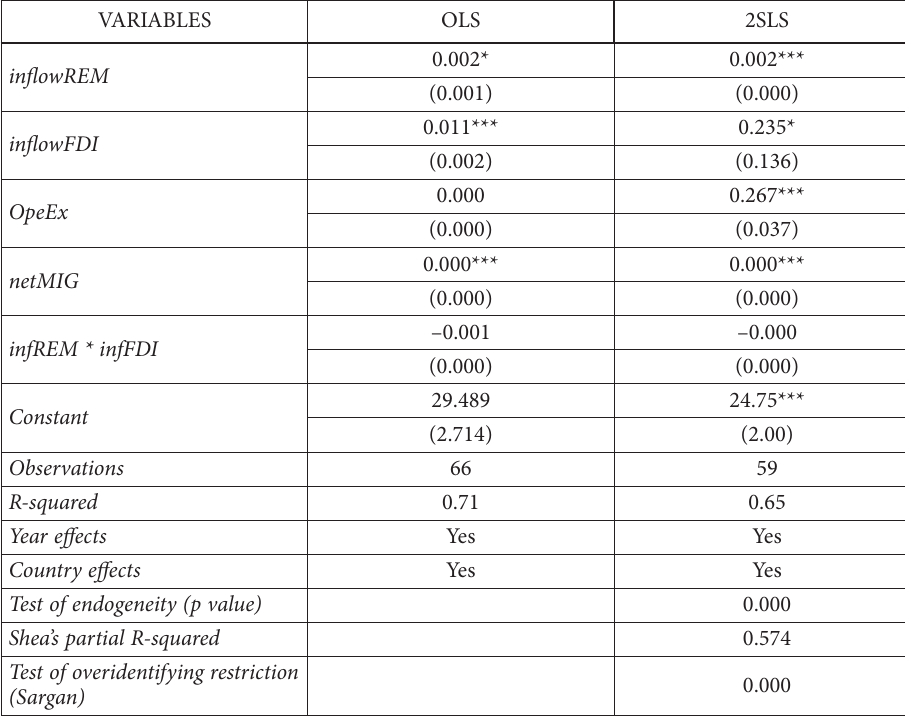
Table 3. Regression estimates of the effect of remittances on